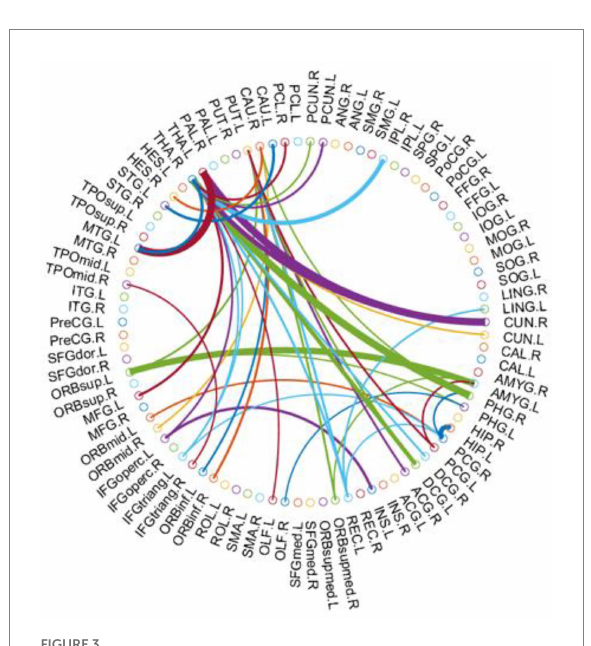
FIGURE 3 The most consensus connections mapped on the International Consortium for Brain Mapping (ICBM) 152 template using the BrainNet Viewer software package http://nitrc.org/projects/bnv/ and circularGraph, shared by Paul Kassebaumb http://www. mathworks.com/matlabcentral/fileexchange/48576- circulargraph. The connectivity matrices of the fully connected network of PD-LCT -L compared to PD-LCT-H are shown. The 43 most significant connections were